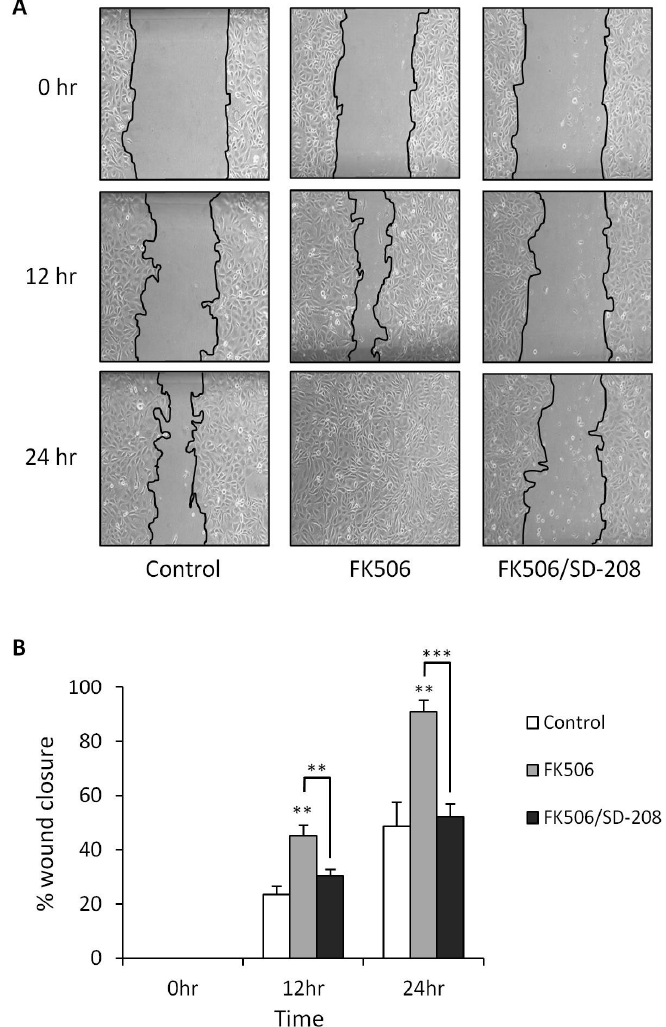
Figure 5. Treatment of HK ‐ 2 RPTECs with FK506 induced increased cell migration which was alleviated following co ‐ treatment with a TGF ‐β RI kinase inhibitor (SD ‐ 208). ( A ) HK ‐ 2 RPTECs were cultured in 12 well plates. At the time of assay, wounds were inflicted on the cell mono ‐ layer using a 200 µ L pipette tip. The mono ‐ layer was then washed twice with PBS and then treated with control medium, medium containing 5 μ M FK506 alone or a co ‐ treatment of FK506 and SD ‐ 208. Phase contrast images were then taken at 0, 12 and 24 h time ‐ points. Representative images are shown from four independent experiments; ( B ) Images were analyzed using ImageJ software to calculate wound area. Data is expressed as the mean values of percentage wound closure relative to the corresponding 0 h time point and represent the mean percentage closure ± SEM ( n = 4): *** p < 0.001; ** p < 0.01 vs time ‐ matched vehicle treated control for each time ‐ point.